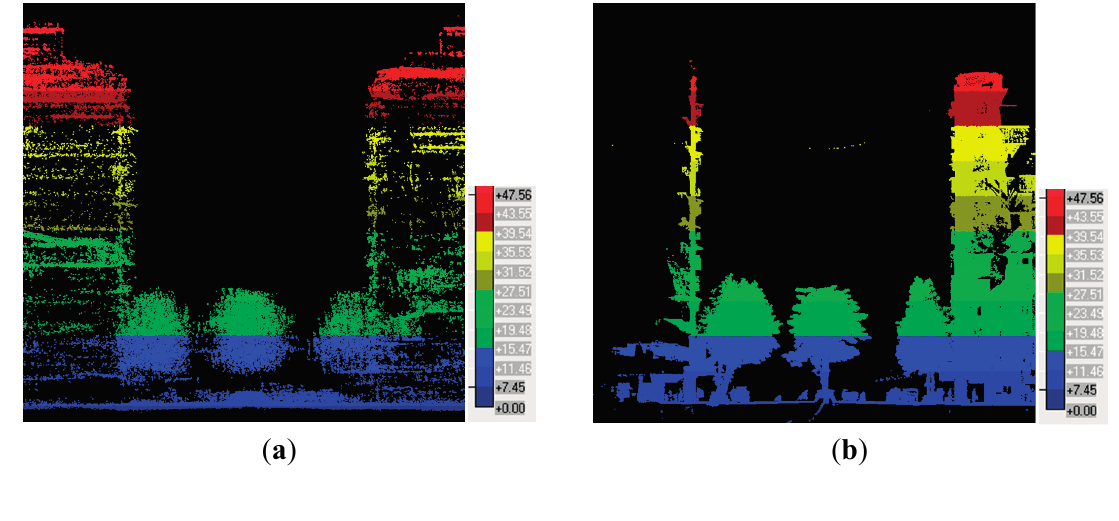
Figure 5. Profiles of ALS and corrected MLS data: ( a ) profile of ALS colored by elevation, ( b ) profile of MLS colored by